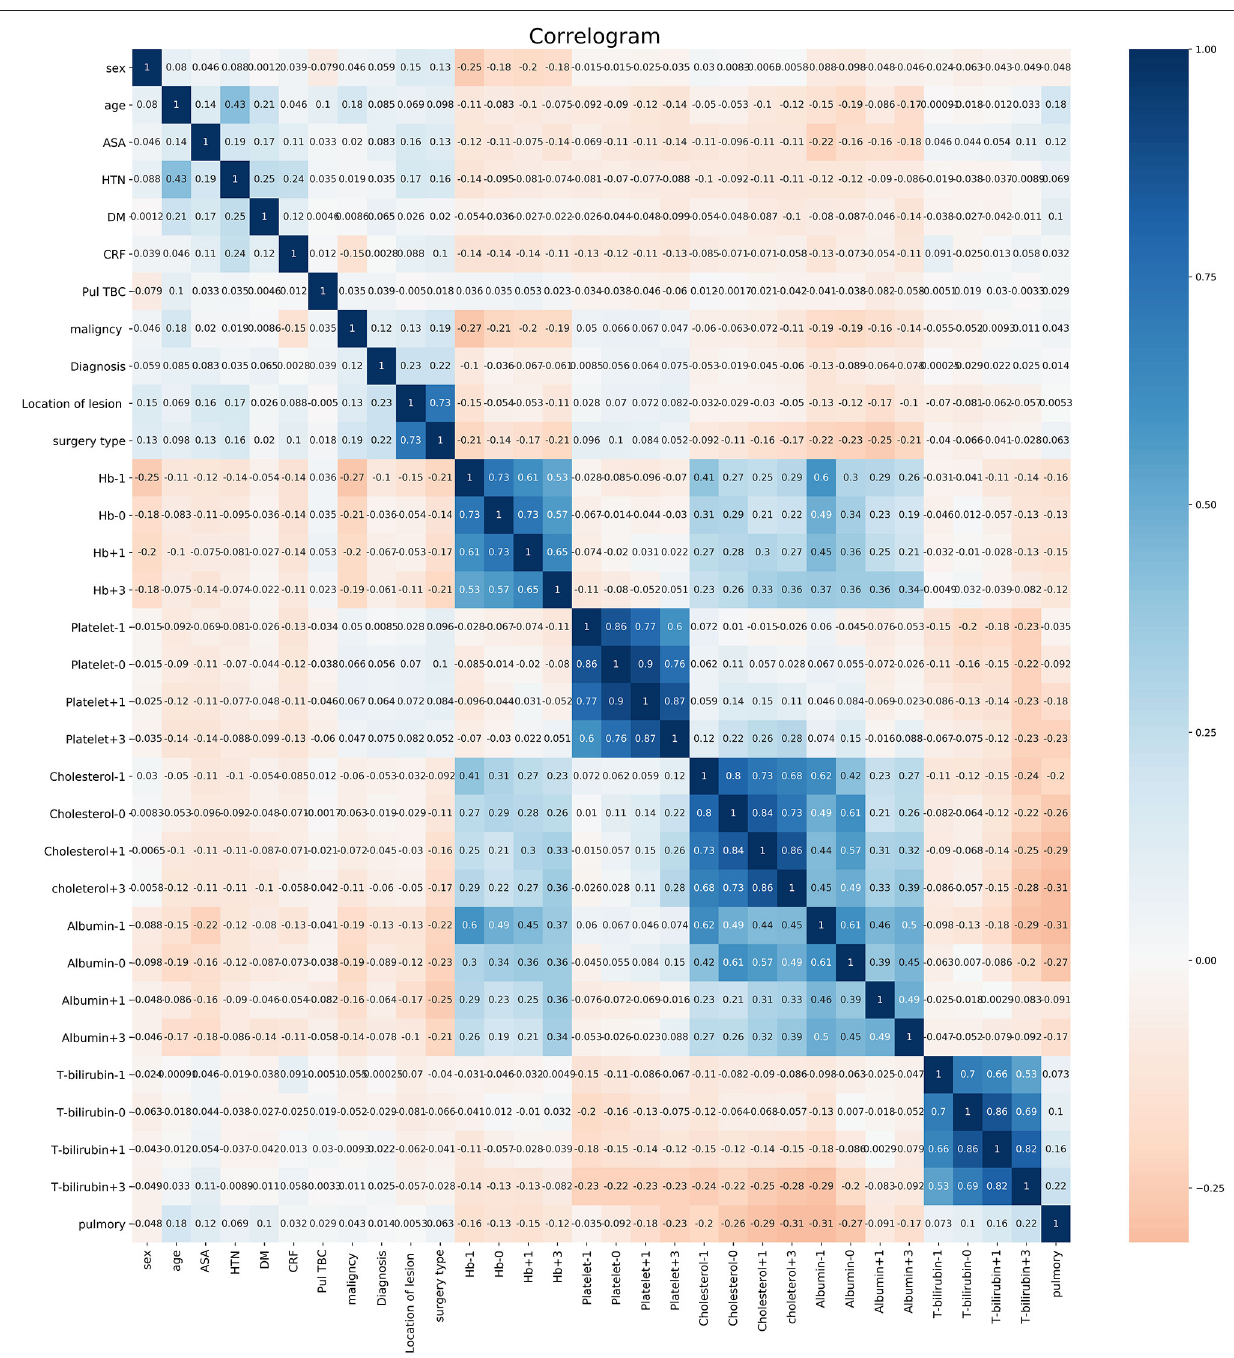
FIGURE 2 | Correlation analysis of various factors.